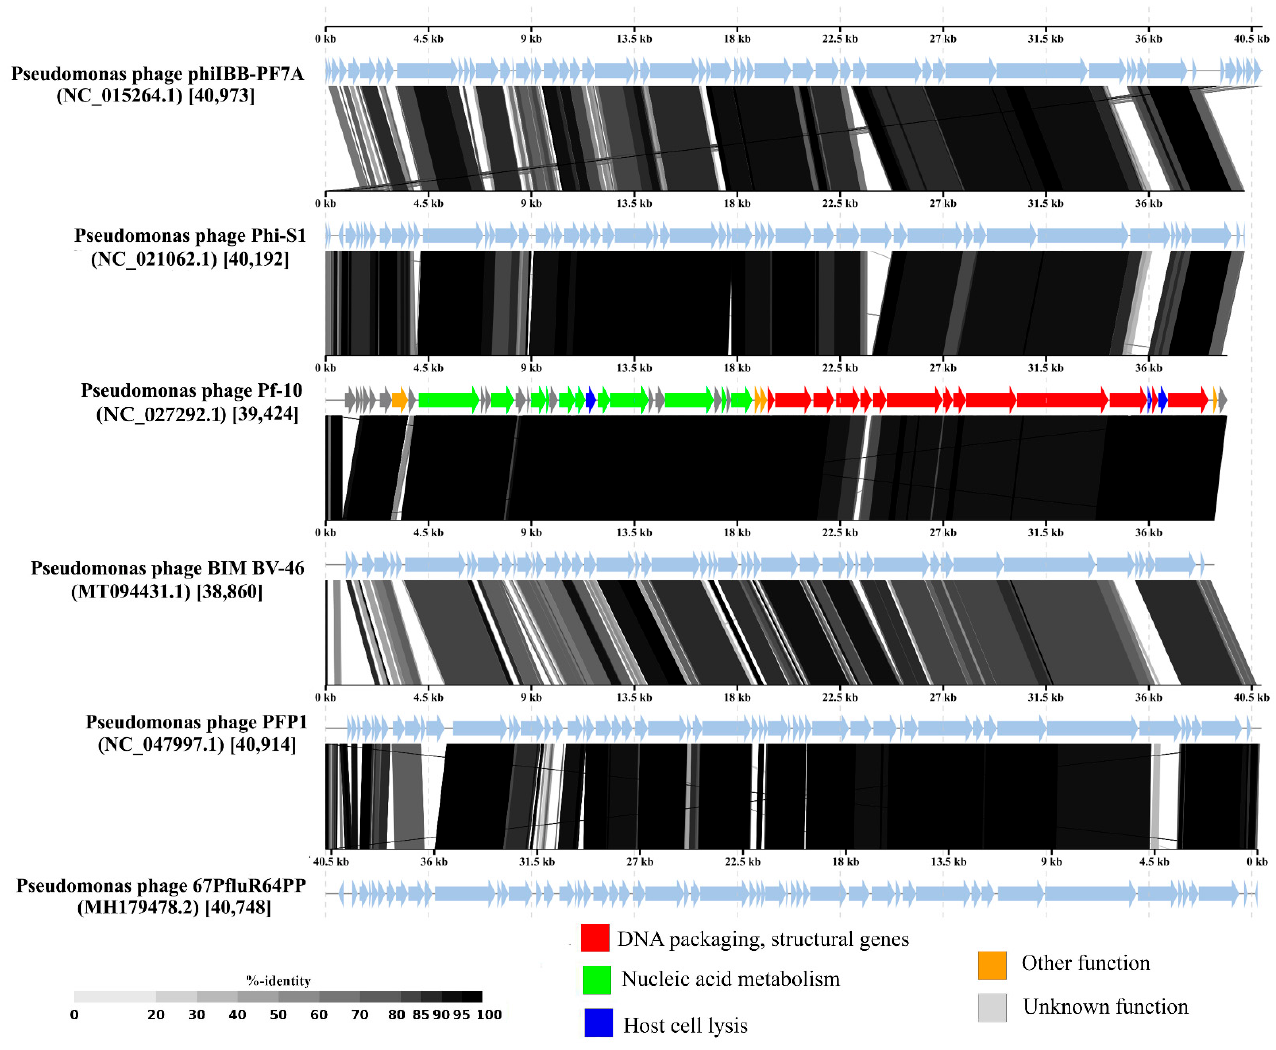
Figure 10. The pairwise tBLASTx comparison of the complete genomic DNA sequences of Pseudomonas phage Pf-10 and the most closely related phages visualized with ViPTree server version 1.9. The Pf-10 genome color scheme corresponds to Figure 6 (see the legend). Gray areas between the genome maps indicate the level of identity.